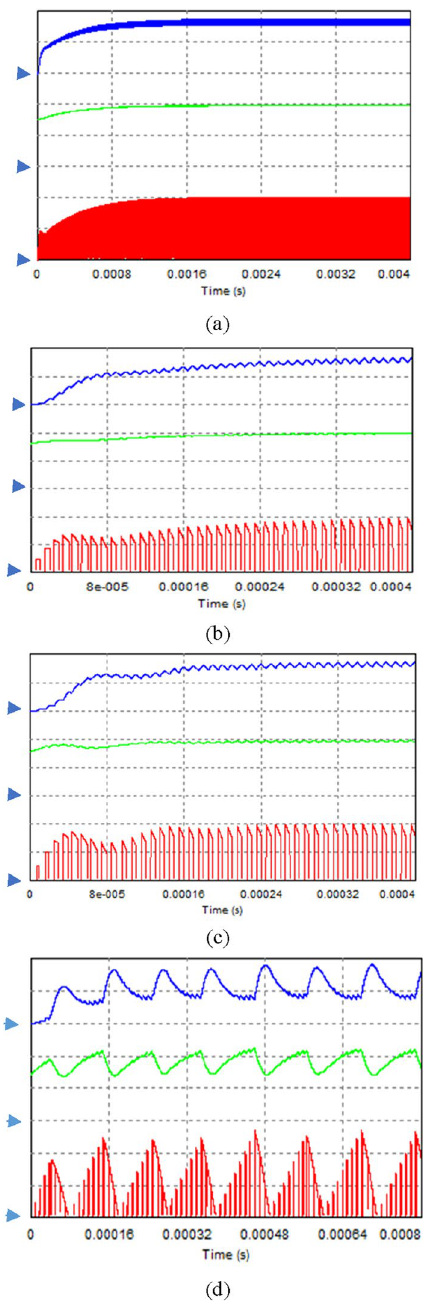
, ( b ) k 3.7 k ) , ( c ) 0.027 ( R ′ R ′ 1 = 12 k Figure 11. Simulated waveforms at start-up, ( a ) k ni ≈ 0.0083 ni ≈ 1 = (cid:31) (cid:30) , and ( d ) k . Vertical scale: top traces-load current i 0.1 k ni ≈ 0.055 R ′ 1 = 1.8 k R ′ 1 = 1 k ni ≈ L (0.5 A/div.); (cid:31) (cid:30) (cid:31) (cid:30) middle traces-error amplifier output voltage COMP (2 V/div); bottom traces- transformer secondary output current i o (1